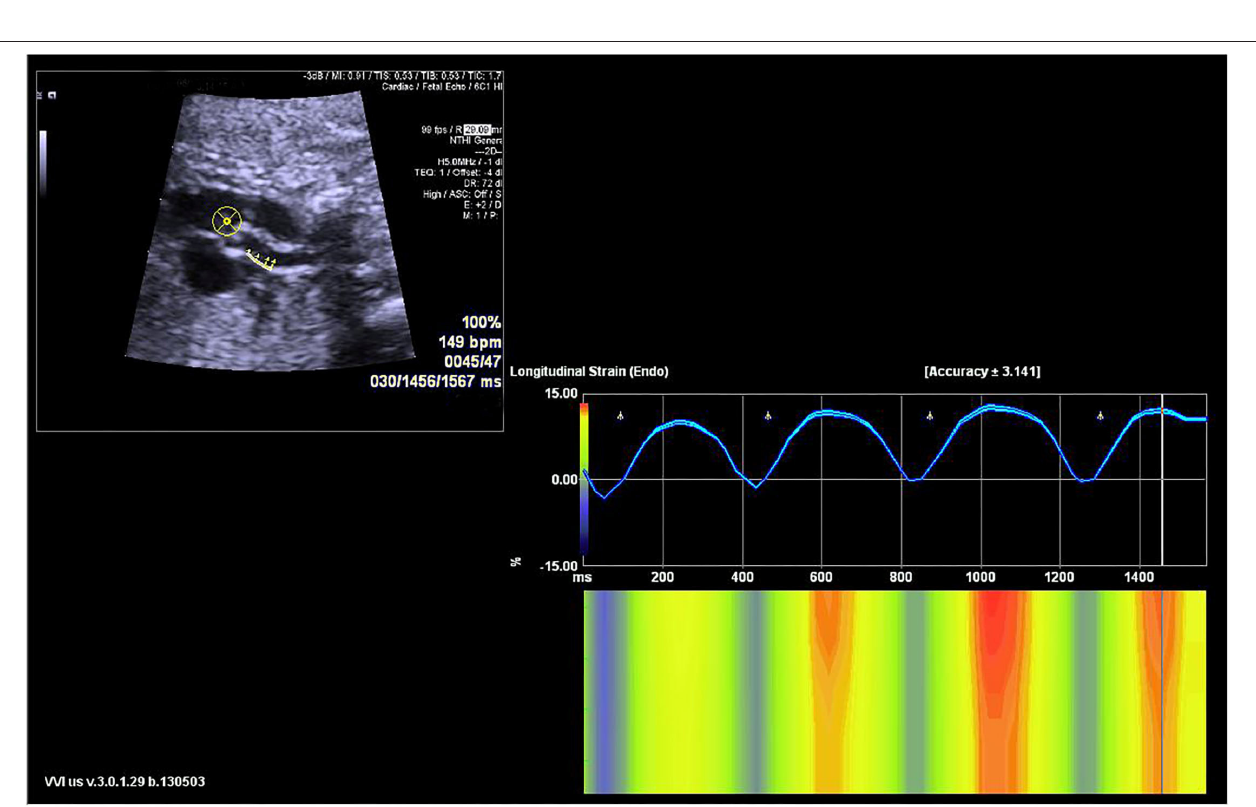
FIGURE 2 | The velocity vector image of the traced posterior ascending aorta wall is shown in the sagittal view (left upper panel) . The longitudinal strain curve of the traced wall was automatically calculated and displayed (right panel)